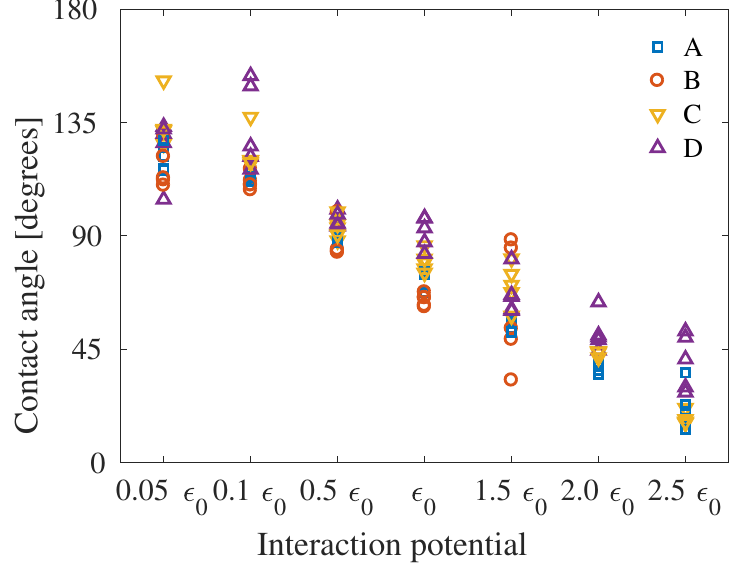
Figure 8. Contact angle as function of interaction energy ε for all system sizes. Separate figures can be seen in Figure S8.